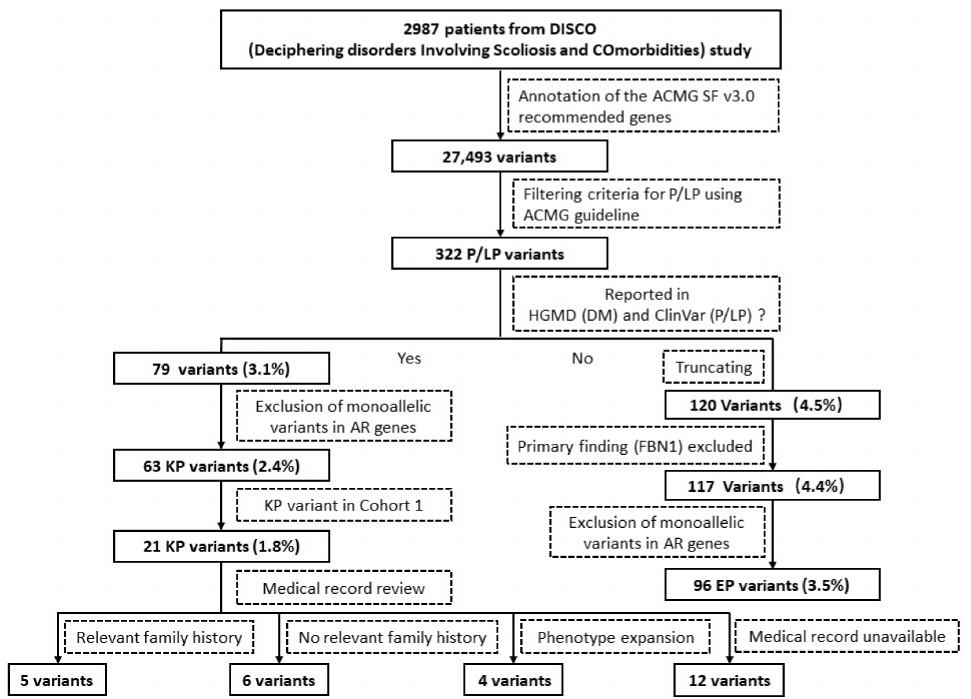
Figure 1. Schematic workflow of the secondary findings (SFs). All the percentages listed in the figure indicate the proportion of SFs variant carriers in our